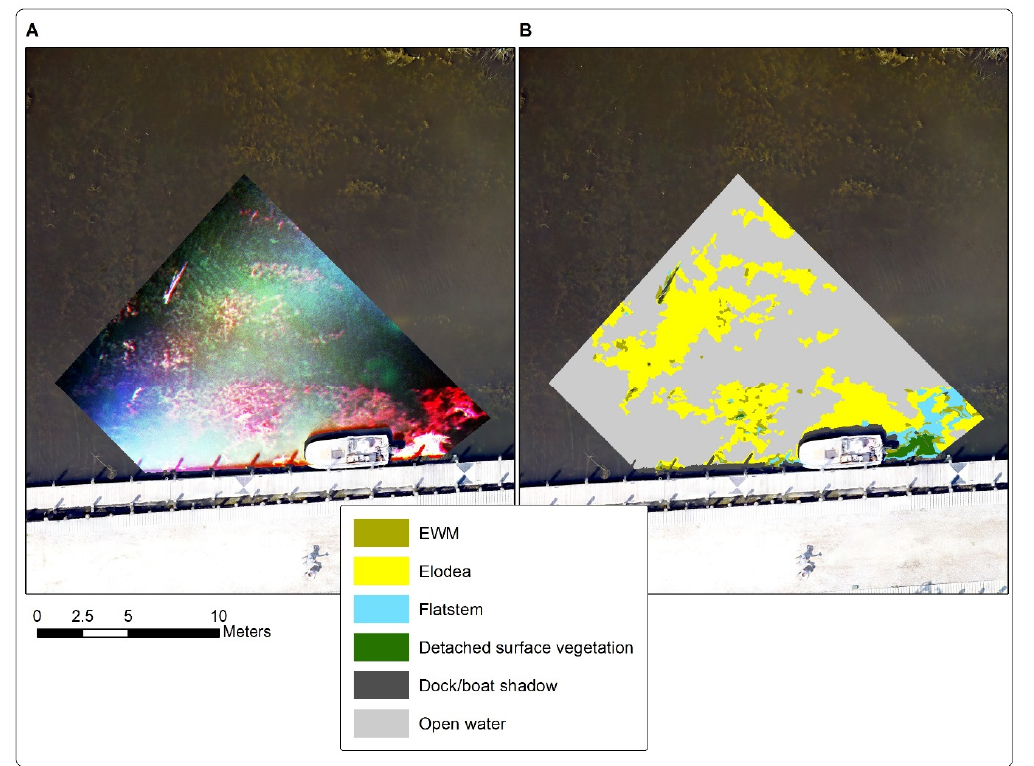
Figure 5. Breezeswept North July 2017 example result, with ( A ) Tetracam imagery and ( B ) classifica- tion result with scale parameter = 50.